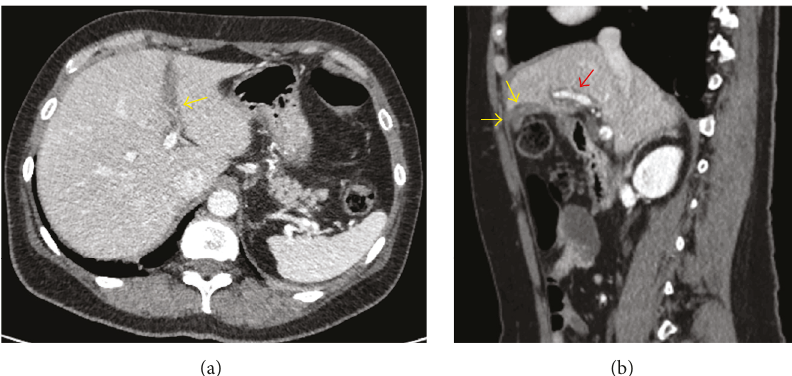
Figure 3: Abdominal axial (a) and sagittal (b) CT scan showing resolution of falciform ligament thrombosis (yellow arrows) with patent left portal vein (red arrow).